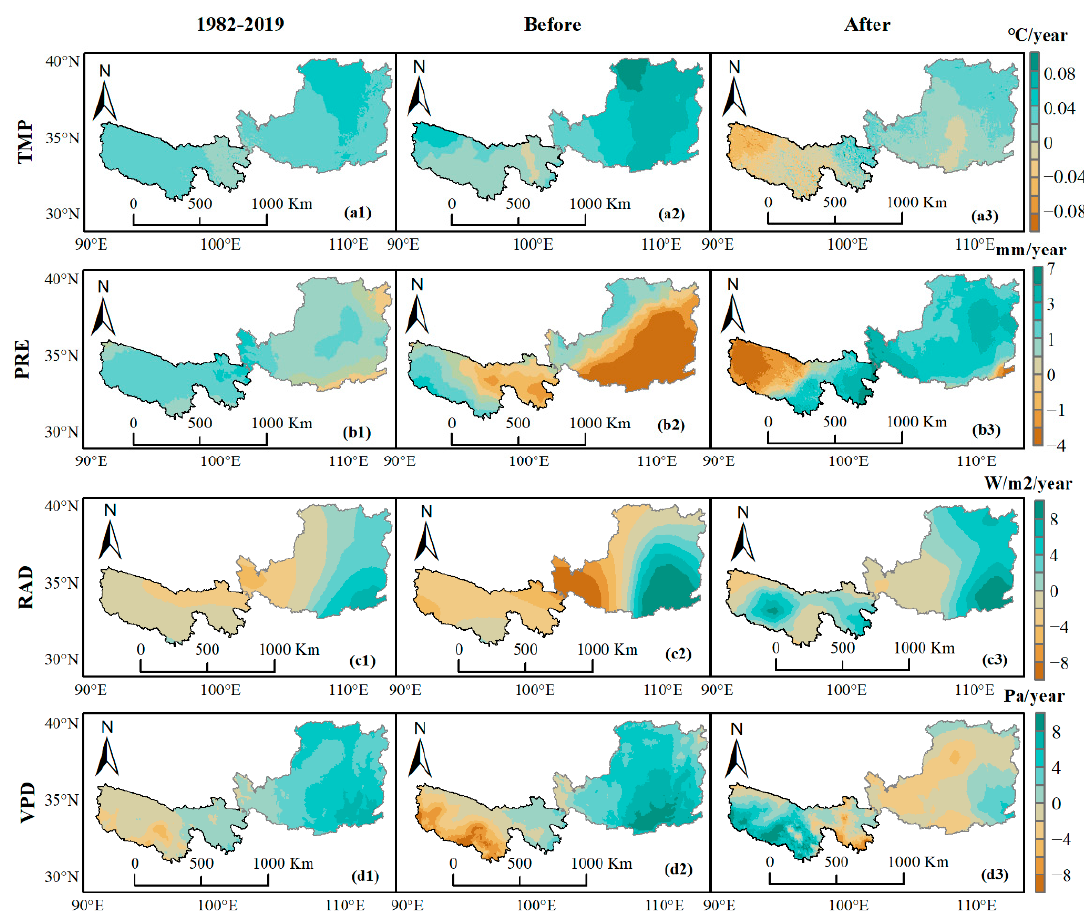
Figure 5. Spatial patterns of the trends in annual mean climatic variables (TMP, PRE, RAD, and VPD) for the three periods: 1982–2019 ( a1 – d1 ), before the implementation of ecological engineering project ( a2 – d2 ), after the implementation of ecological engineering project ( a3 – d3 ). TMP, PRE, RAD, and VPD represent temperature, precipitation, downward surface shortwave radiation, and vapor pressure deficit, respectively.